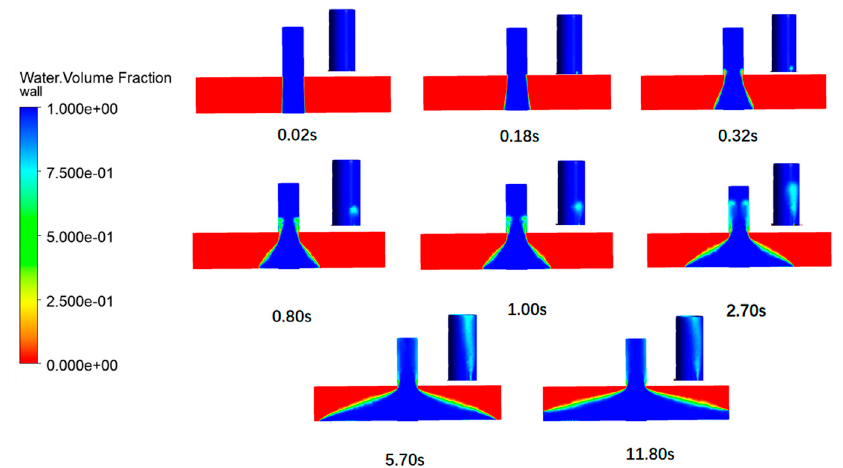
Figure 2. Gas invasion simulation volume fraction distribution.